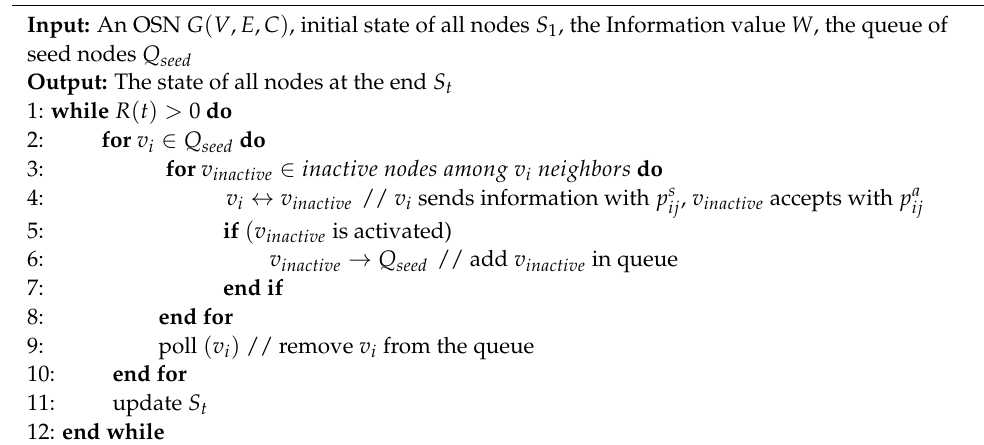
Algorithm 1 Information diffusion based on IDBESW model